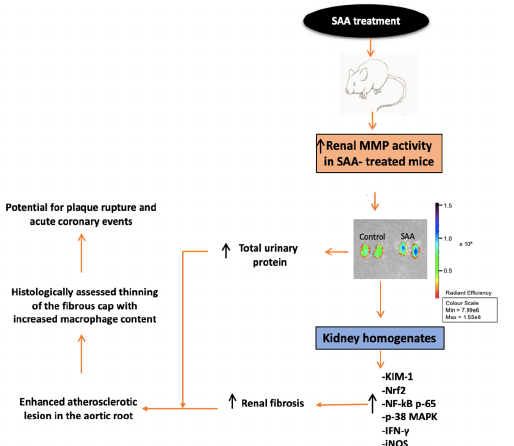
Figure 11. Schematic flow chart summarising the biological implications to kidney and vasculature in mice stimulated with pathological amounts of SAA that simulated an acute phase response over 2 weeks, with follow up at 4 and 16 weeks after cessation of the 2-week period of SAA administration in mice. Authors Contributions: P.K.W. and G.A. designed and supervised the experimental work. A.G. and S.G. performed lab experiments. H.S. and A.L.S. helped in experimental work. G.A. and Y.L. conducted animal studies. A.G. and S.G. wrote the first draft. P.K.W. and G.A. revised and proofread the manuscript. All authors have read and agreed to the published version of the manuscript.